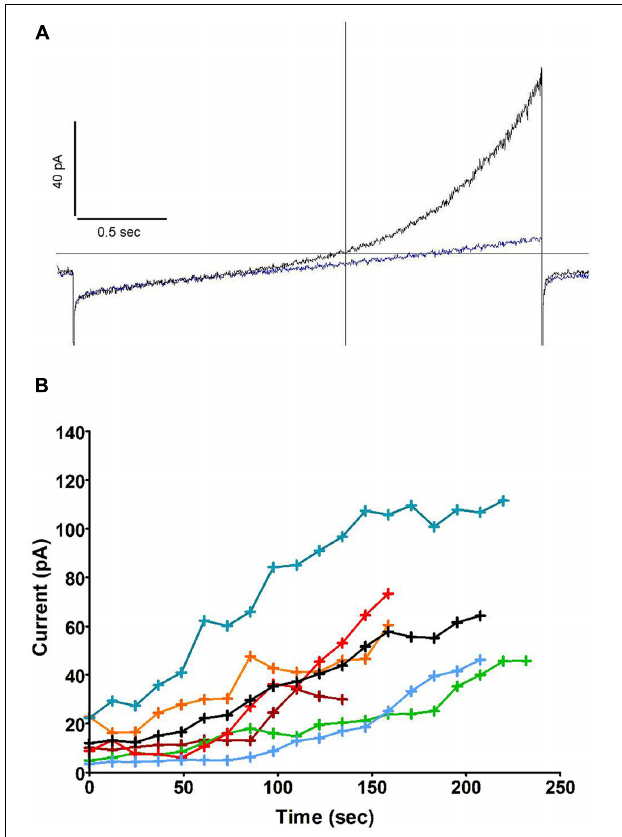
FIGURE 1 | An outward current develops after breakthrough and counteracts the oxidase induced depolarisation. (A) Whole cell current in human neutrophils in response to depolarising 2.6 s long voltage ramps from –127 to +93 mV at 48 s (blue trace) and 160 s (black trace) after breakthrough (holding potential: –87 mV). (B) Time course of the outward current increase measured at +93 mV (i.e., at the top of voltage ramps such as shown in A ) in 6 cells using solutions from set A ( Table 1 ). The average trace is in